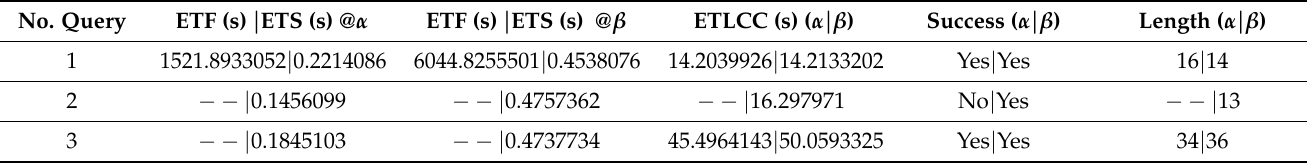
Table 7. Executiontime for case study 2 (5 DOF manipulator). ETF: execution time spent for the incomplete LU factorization, ETS: execution time spent to solve the linear system using ILU factors, ETLCC: execution time spent in the LCC